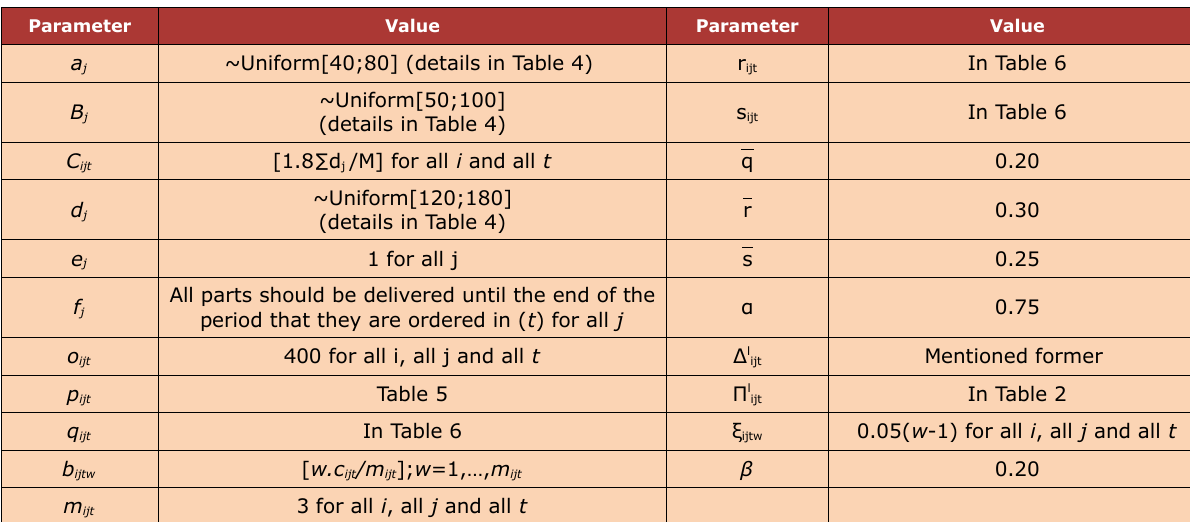
Table 3. Values of all parameters